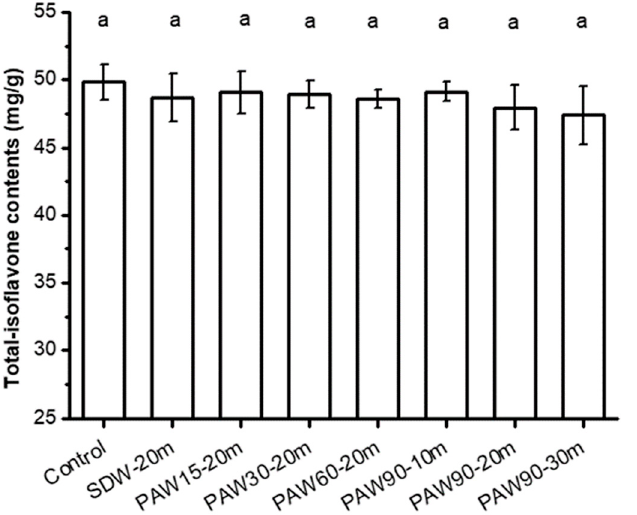
Figure 3. The total isoflavone content of the thin sheets of bean curd with and without treatments. The same letters in the bars indicate no significant difference with each other ( p > 0.05).